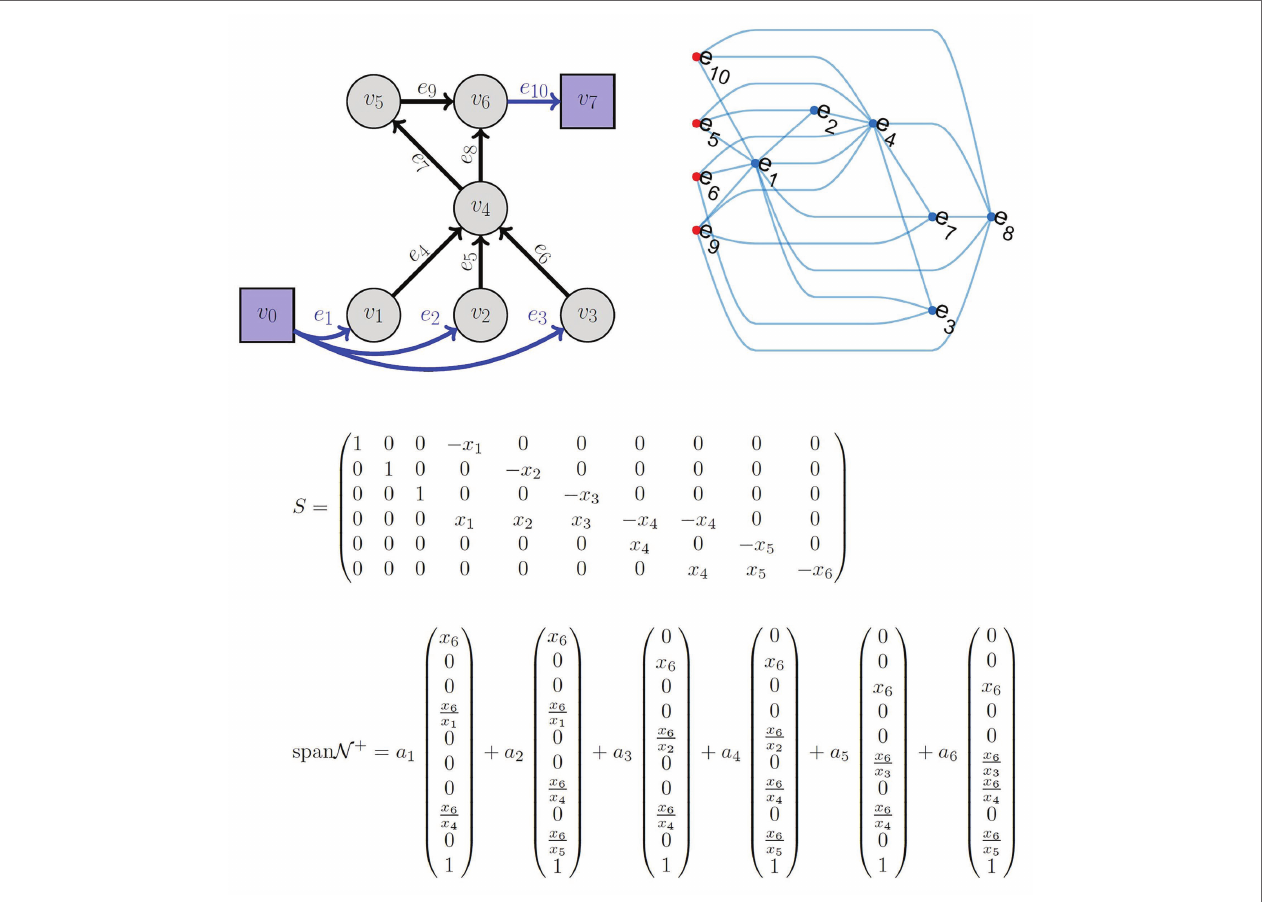
FIGURE 3 | Top left : Example of a metabolic network known as reverse cholesterol transport in humans, described in reference McQuade et al. (2017). Top right : Graph of flux correlations. The nodes correspond to edges from the network. The relationships between fluxes in a cholesterol metabolism model at equilibrium. Nodes in the graph are fluxes. Red nodes to the left indicate independent fluxes and blue nodes are dependent fluxes. An edge between a red node and another node indicates that the expression for the dependent flux contains the independent flux. Dependent fluxes have edges between them when they share a dependent flux. Middle : The matrix S is the linear-in-flux-expression (LIFE) version of the stoichiometric matrix corresponding to the top left network . x 1 corresponds to v 1 , etc. Bottom : The span of the positive null space is shown. Note that the nullity of S is 4. However, the positive basis requires six positively independent elements. The positive basis permits choosing ai ≥ 0 results in flux vectors that lie in the null space of S and the positive